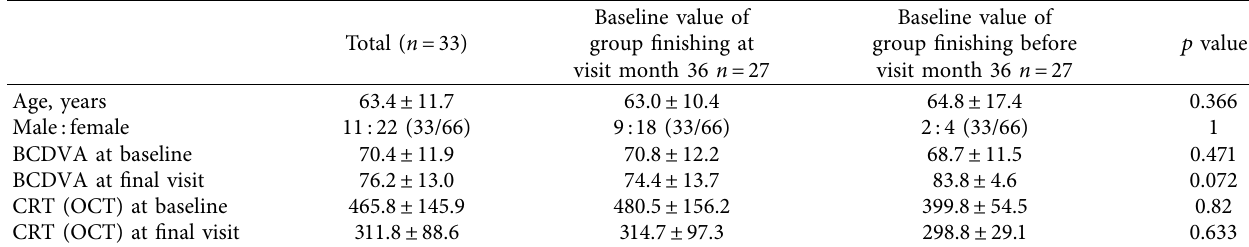
Figure 1: After a patient was included in the study, 5 monthly injections were admitted as loading dose. 2months after the ffth injection, the patient went to the practitioner’s ofce for OCTscan and funduscopic examination. If a macular edema is present, the patient was referred to our clinic for reevaluation and injection if indicated. Table 1: Age, sex, and baseline-values for BCDVA and CRTfor the whole study population and for the subgroups who had their fnal visit at month 36 or before the month 36. Te p value describes the diference of the visual acuity and the central retinal thickness at the baseline and at the fnal visit between the two